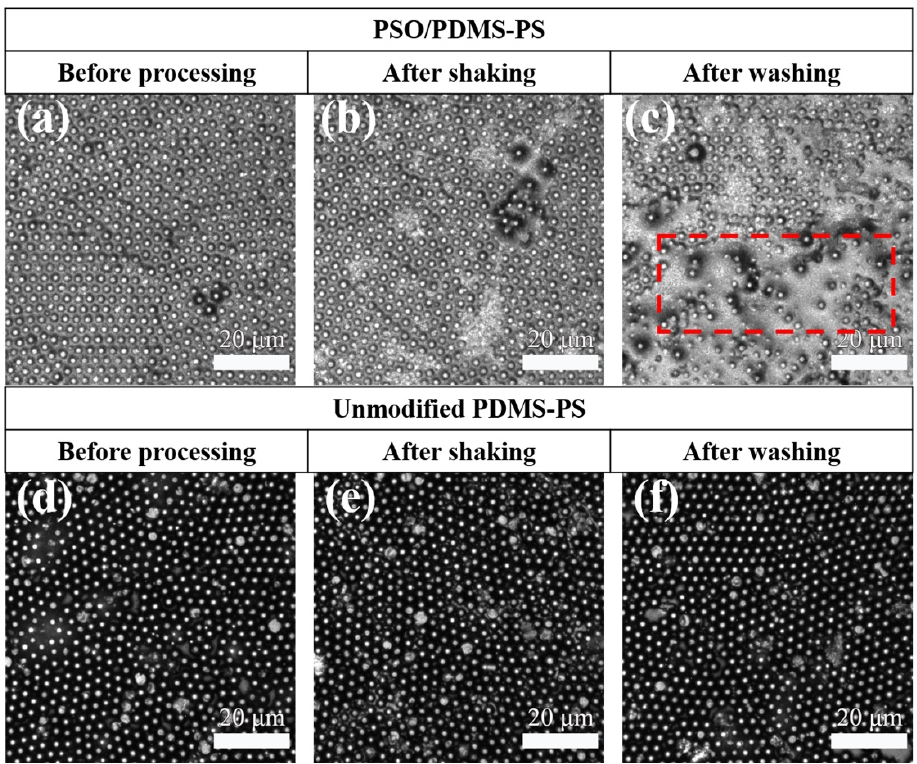
Figure 2. ( a – c ) are the laser confocal images of PSO/PDMS-PS before processing, after shaking and after washing, respectively; ( d – f ) are the laser confocal images of unmodified PDMS-PS before processing, after shaking and after washing, respectively. It is noteworthy in ( c ) that the PS microspheres in the red dashed box are covered by the exuded silicone oil, which make them invisible.